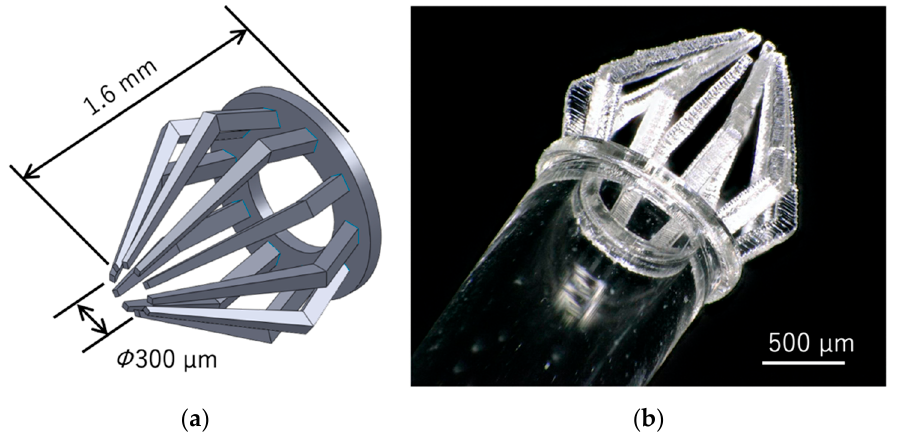
Figure 5. Microfingers mounted on a glass capillary: ( a ) 3D CAD model; ( b ) Bird’s eye view.